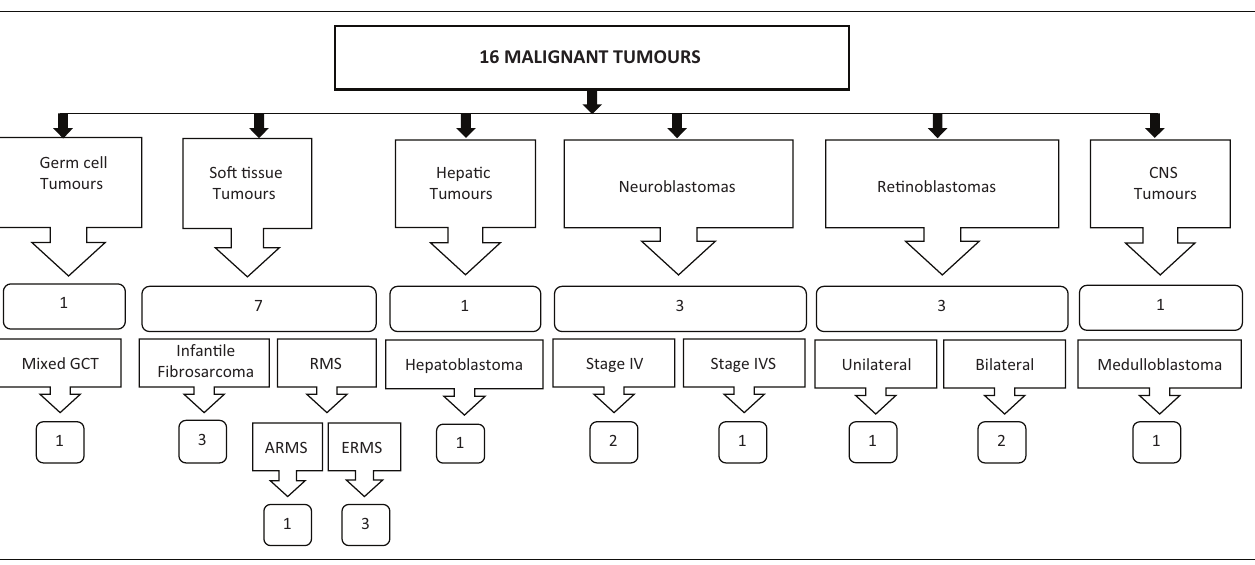
FIGURE 1: The distribution of patients diagnosed with benign neonatal tumours.